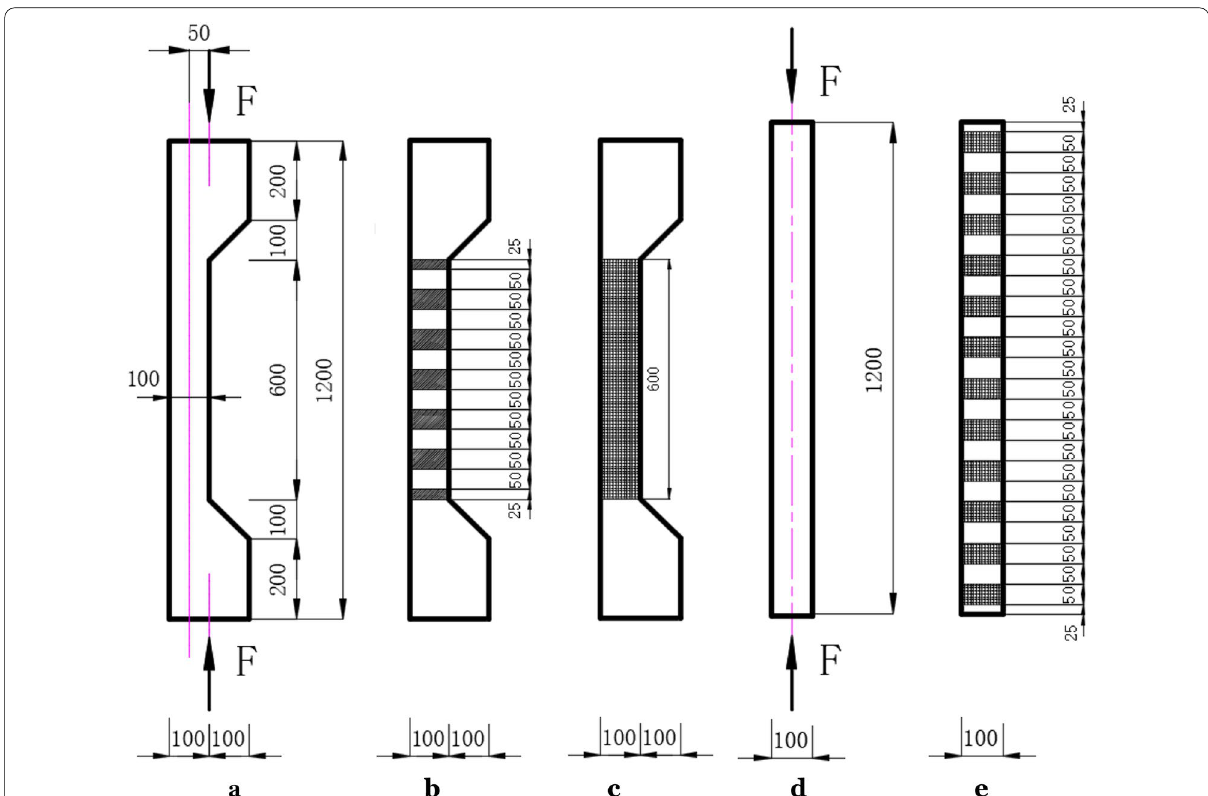
Fig.4 Specimen size and BFRP bonding method: eccentric columns: a DBZ, b JB1 and JB2, c MB1 and MB2, axial compression columns: d DBZ, and e JB1 and JB2 unit: